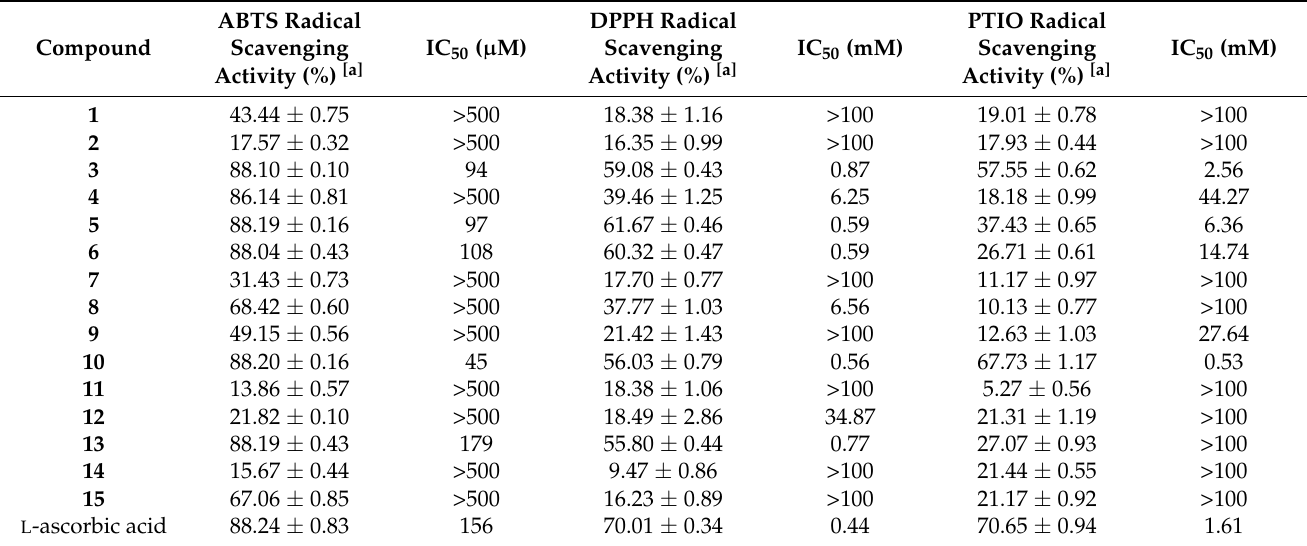
Table 1. ABTS, DPPH and PTIO radical scavenging activities of 1 – 15 .